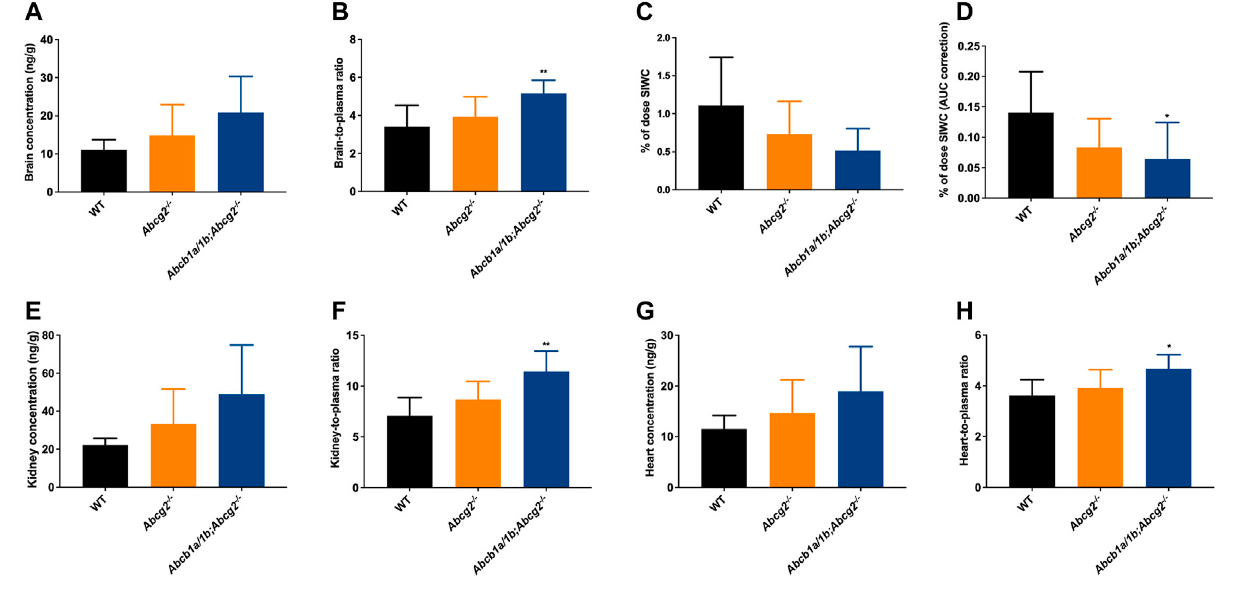
Frontiers in Pharmacology |